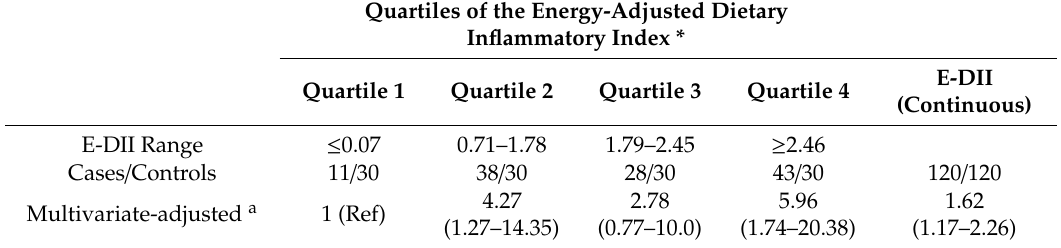
Table 4. Odds ratios (OR) and confidence intervals for quartiles of energy adjusted Dietary Inflammatory Index (E-DII) associated with the diet of patients with